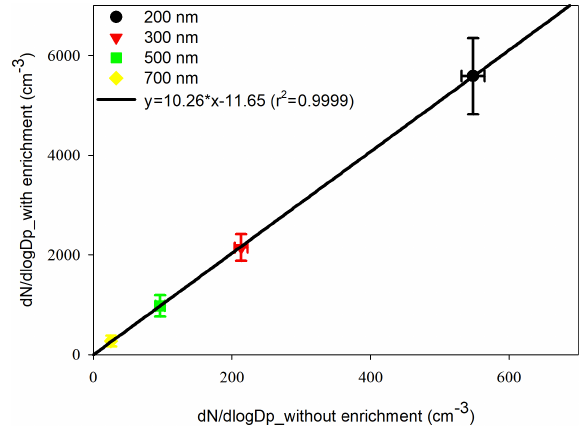
Figure 2. Calibration of enrichment factor of VACES system using polystyrene latex (PSL) aerosol reagent 200–700nm in size. Error bars are the standard deviation of six parallel